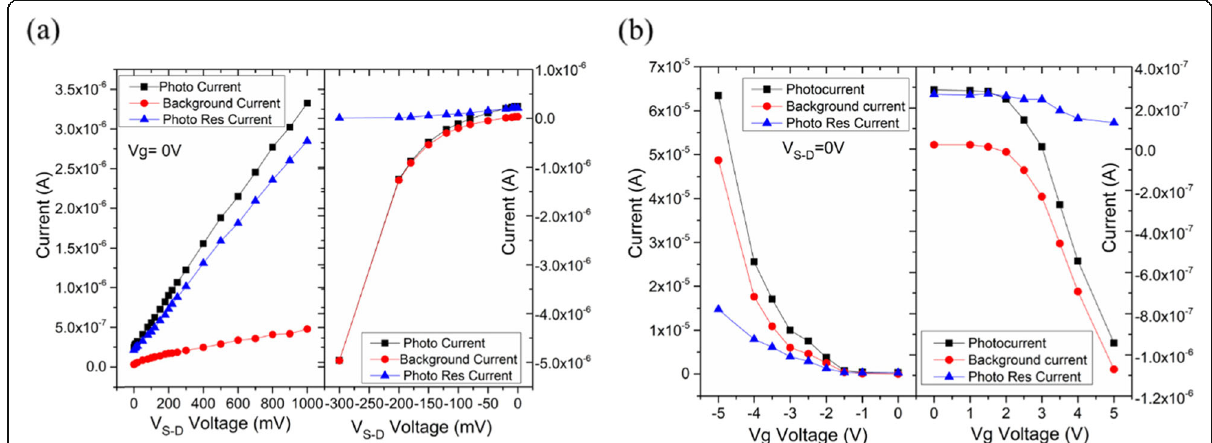
Fig. 3 a Photocurrent dependence on the biased source-drain voltage. Photocurrent, background current, and photoresponse current measurements of GRN photodetector in biased of back-gate voltage. The decrease of the photocurrent with an increase of the biased source-drain voltage was contributed to the improvement of the separation efficiency of photo-generated electron-hole pairs. b Photocurrent dependence on the back-gate